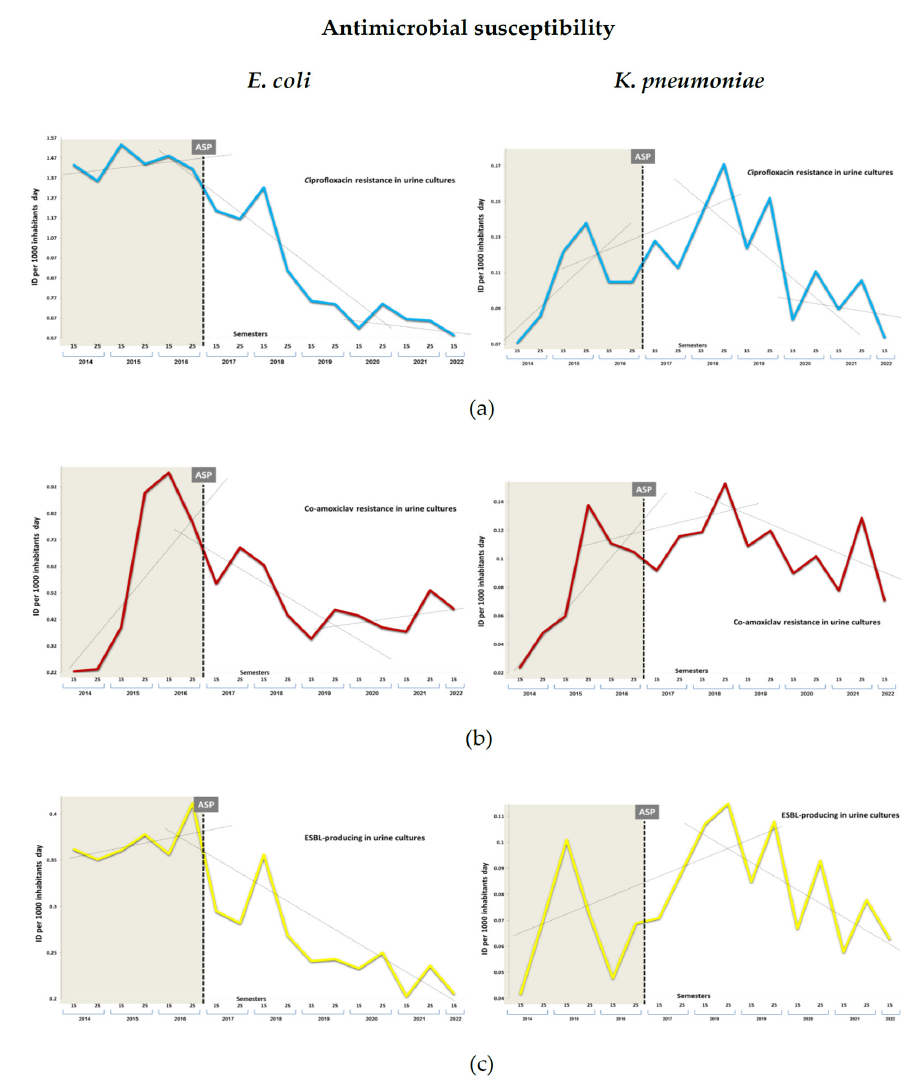
Figure 4. Semestral evolution of antibiotic-resistant E. coli and K. pneumoniae in urine cultures per incidence density (ID) per 1000 inhabitants/day. ( a ) Ciprofloxacin resistance, ( b ) co-amoxiclav resistance, ( c ) extended-spectrum B-lactamase (ESBL).